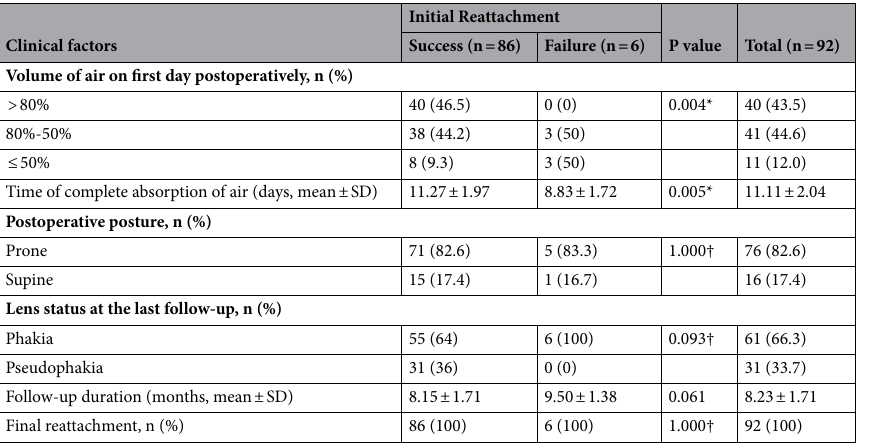
Table 2. Postoperative Clinical Characteristics of Patients. † Fisher’s exact test. *Mann–Whitney U test.